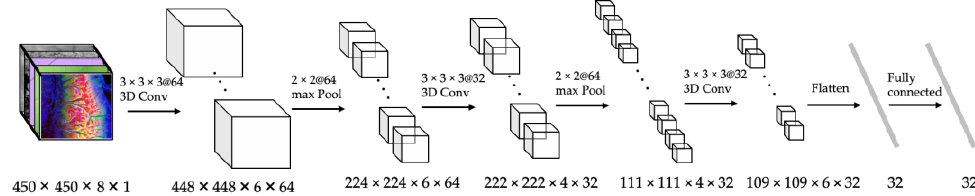
Figure 7. An example of a CNN-based feature extraction for wildfire disaster.